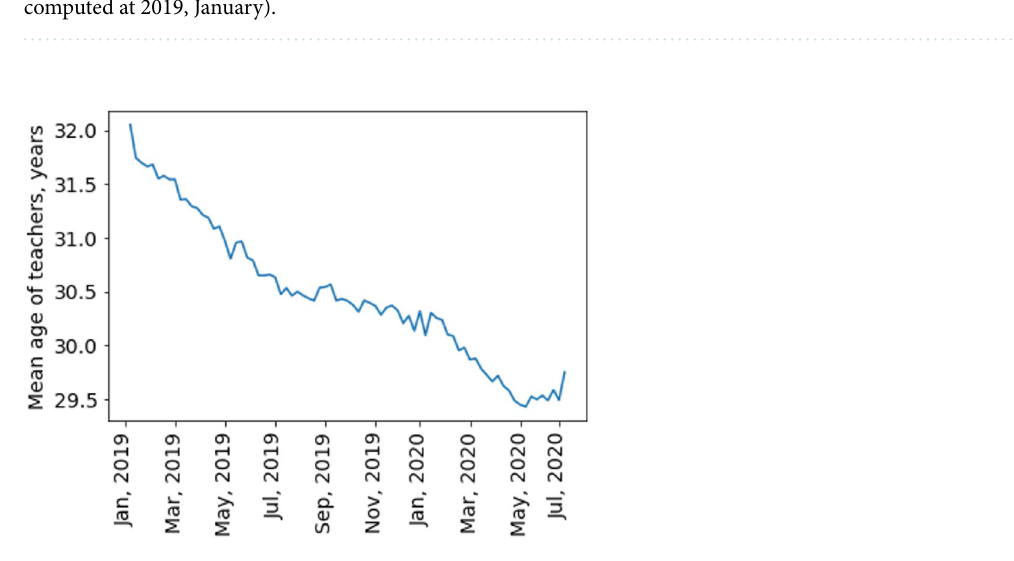
Figure 9. The dynamics of mean age of Skyeng